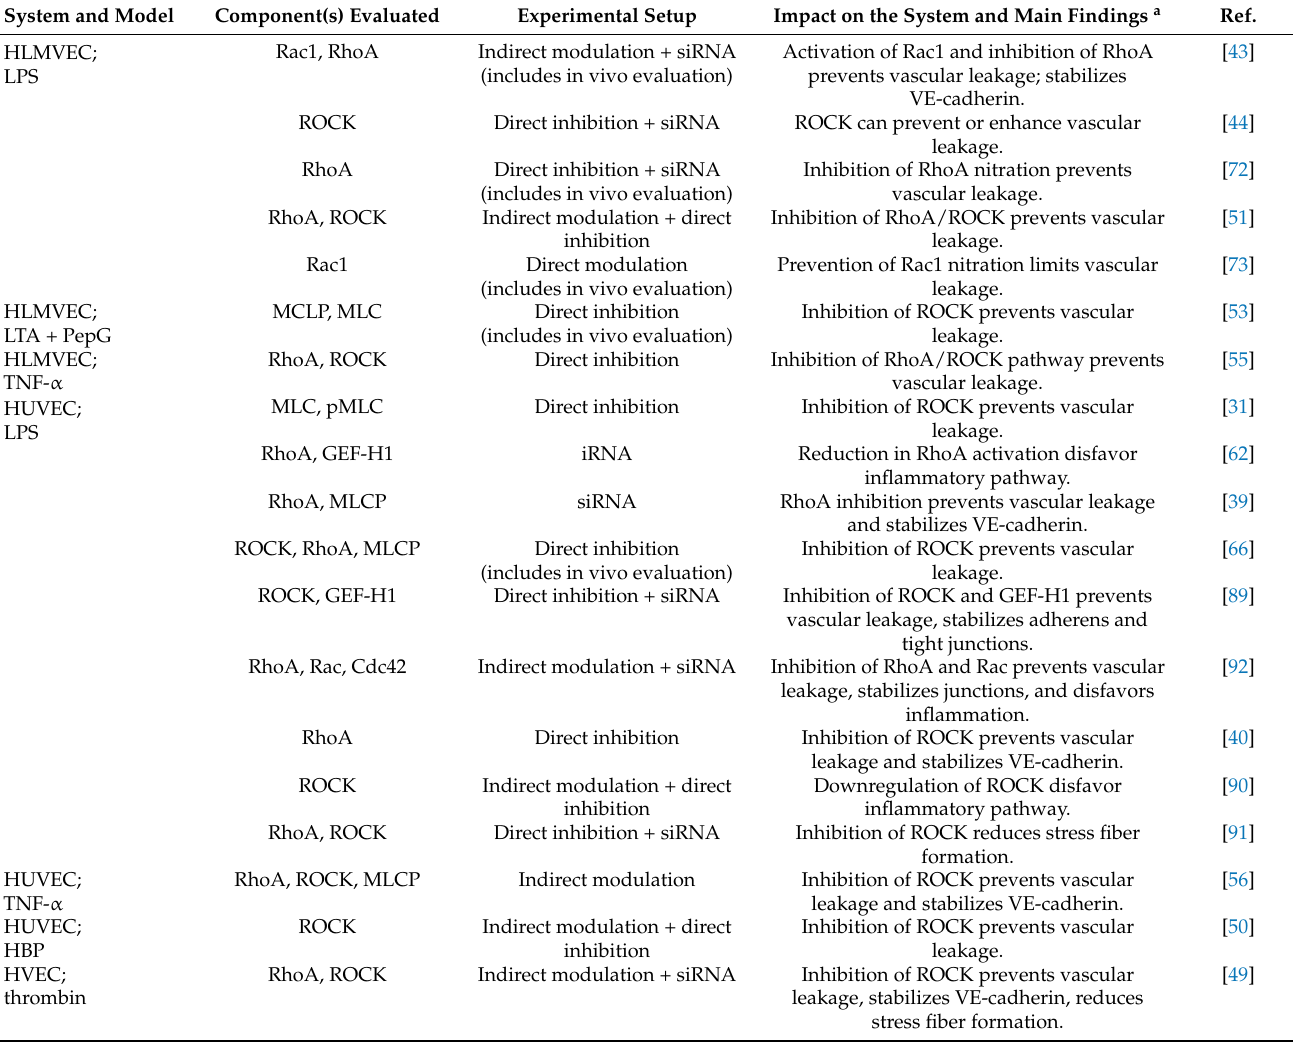
Table 1. The involvement of Rho proteins and downstream pathways in the endothelial function as found in sepsis- associated experimental models.